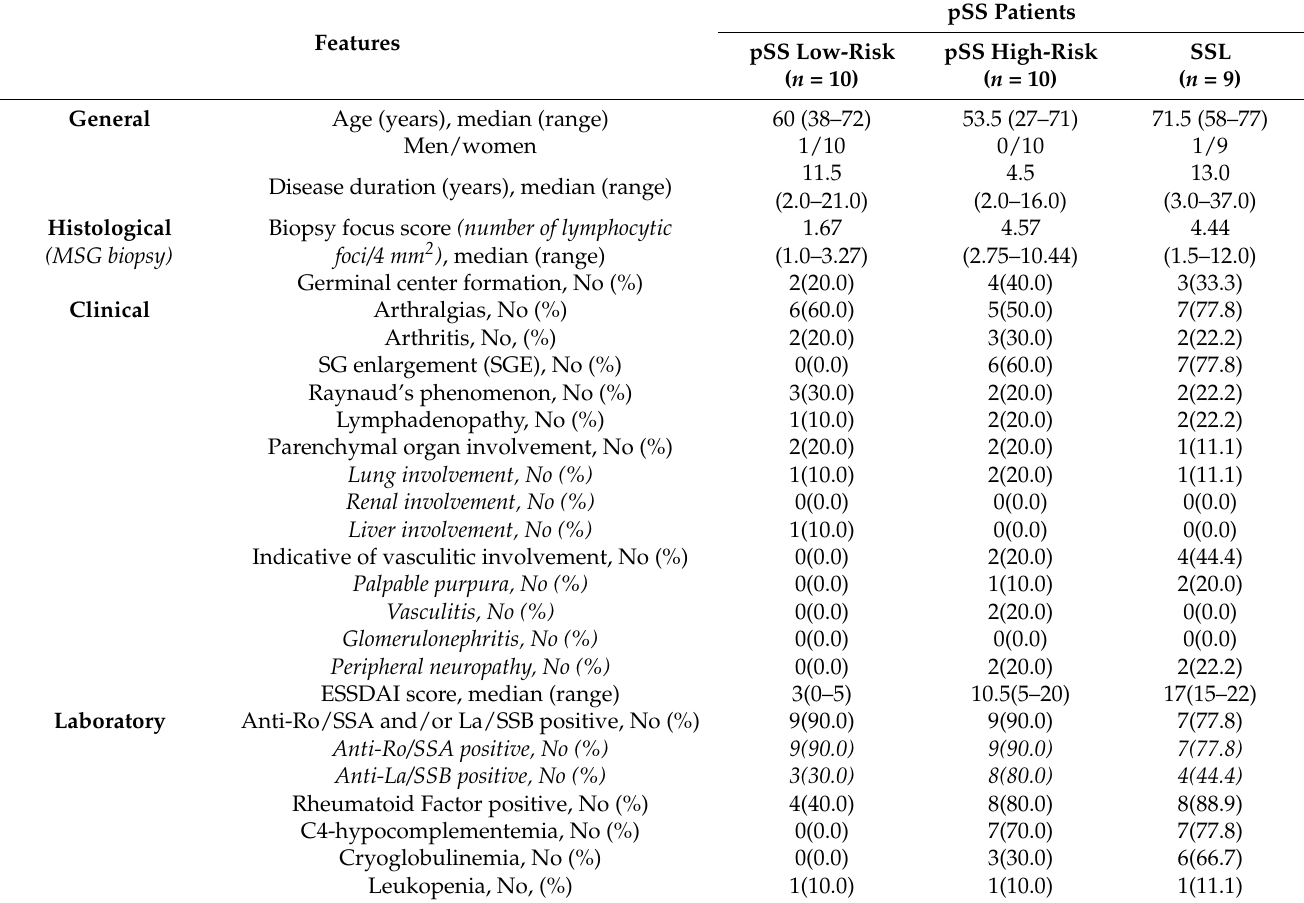
Table 1. Characteristics of the pSS patients studied. These included patients (a) at low risk of developing NHL (pSS low-risk), (b) at high risk (pSS high-risk), and (c) having NHL